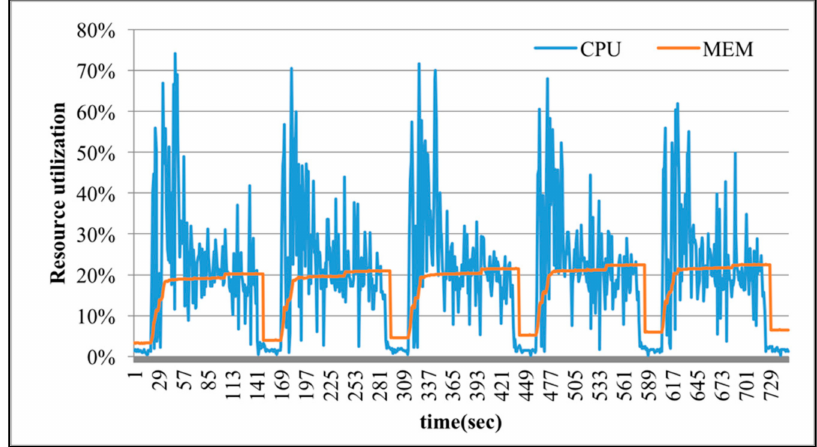
Figure 9. Resource utilization of executing SparkTC when over-commit with 32 vCPU demands.